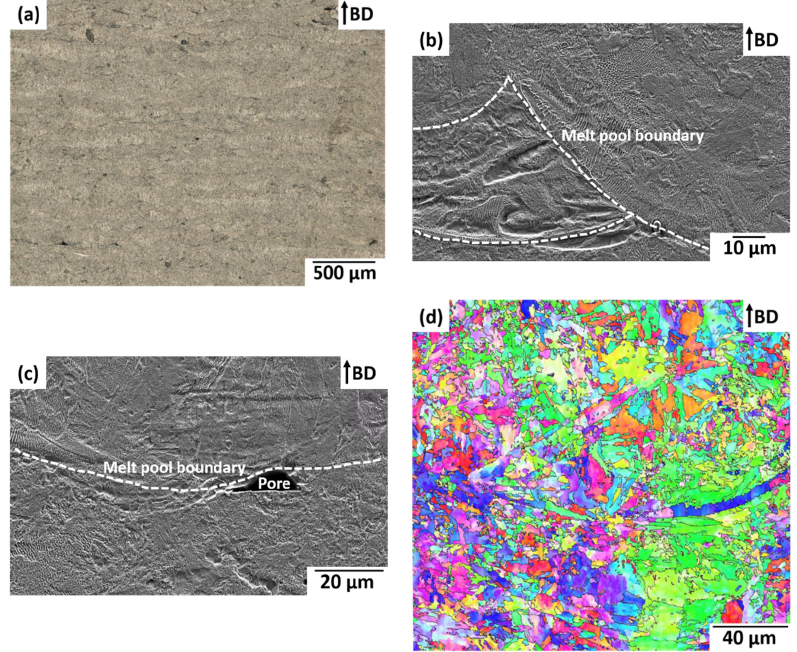
Figure 6. ( a ) Optical micrograph, ( b , c ) SEM micrograph and ( d ) EBSD micrograph of the as-built sample.